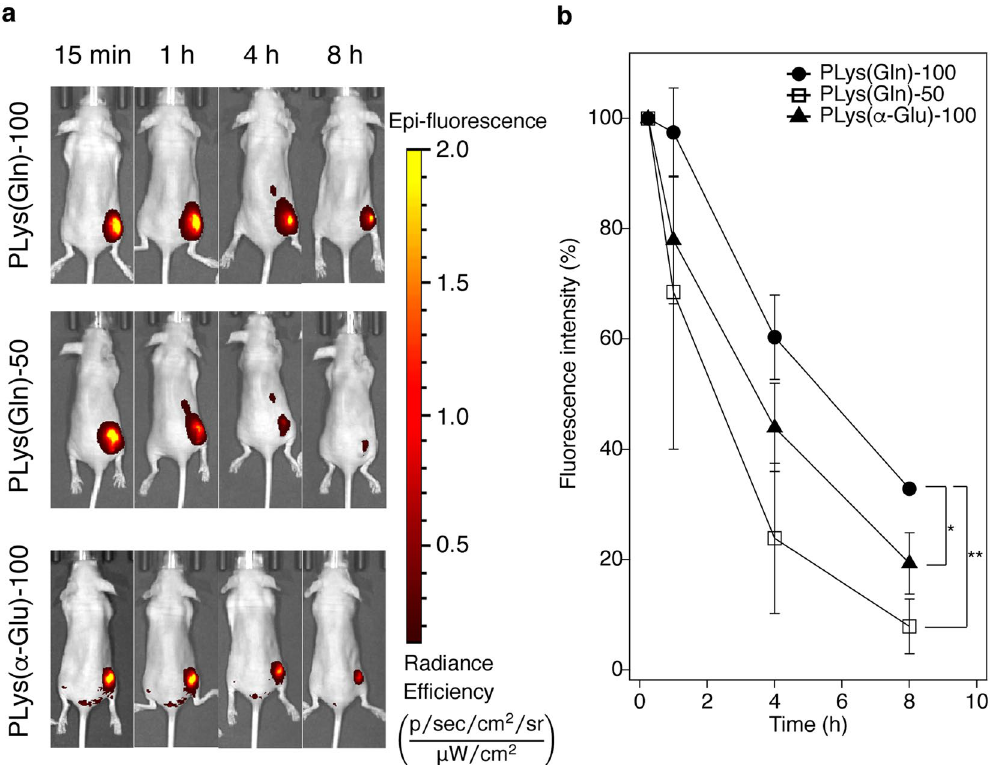
Figure 6. In vivo tumour retention of the polymers after intratumoral injection. ( a ) Representative images of mice bearing subcutaneous BxPC3 tumours after intratumoral injection of the polymers. Images were taken by in vivo imaging system (IVIS). ( b ) Cy5 fluorescence intensities from the intratumorally injected polymers at subcutaneous BxPC3 tumour. Data are mean ± S.D. (n = 3). p * < 0.05, p ** < 0.01 (two-way ANOVA with Tukey’s multiple comparison